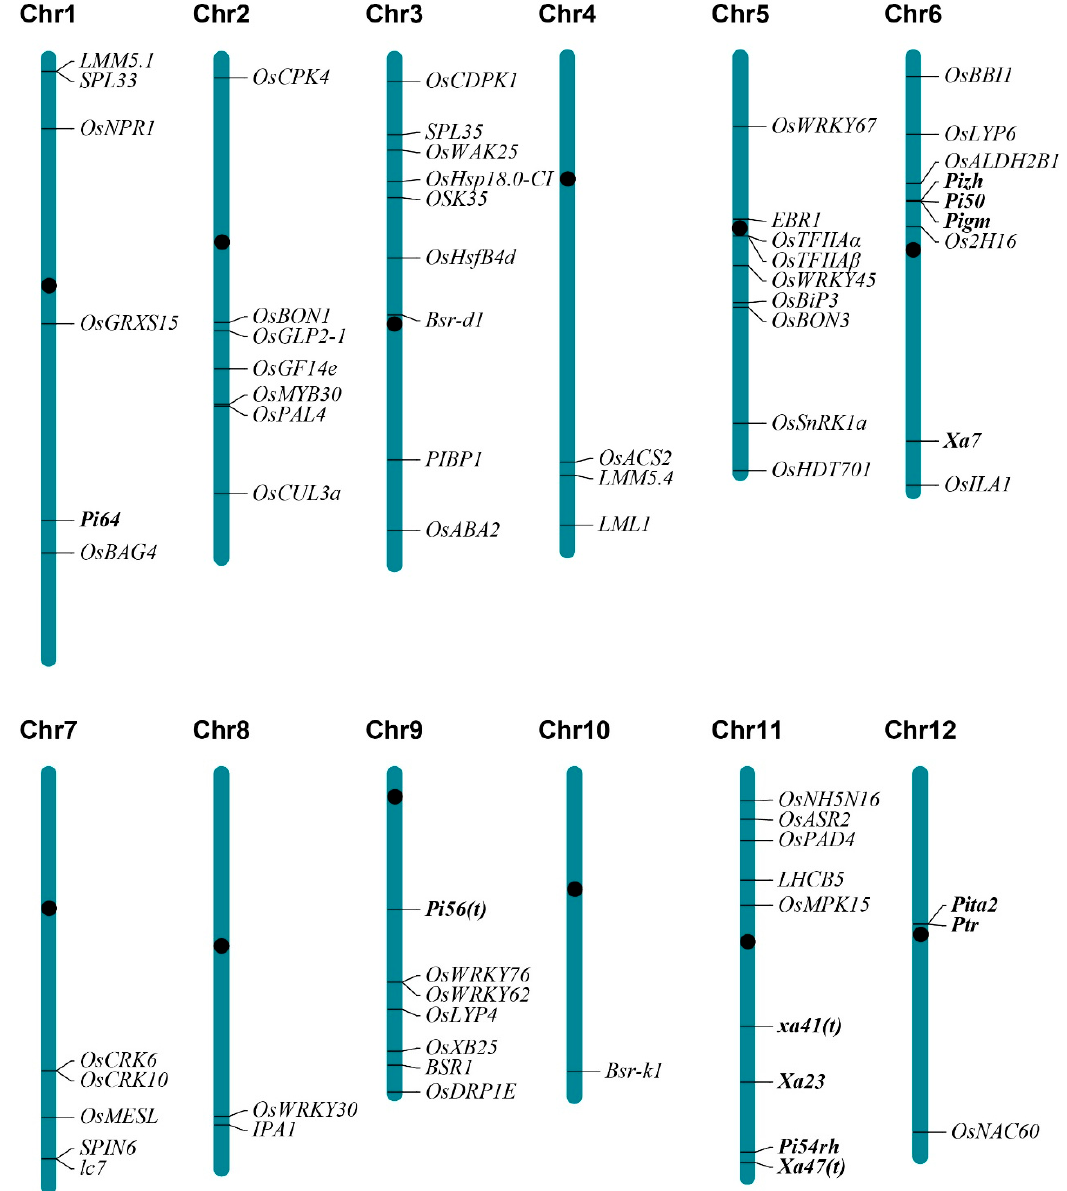
Figure 1. R and defense regulator genes with broad-spectrum disease resistance identified in past 10 years. The R genes are represented in bold black font. The black dots on each chromosome represent centromeres.